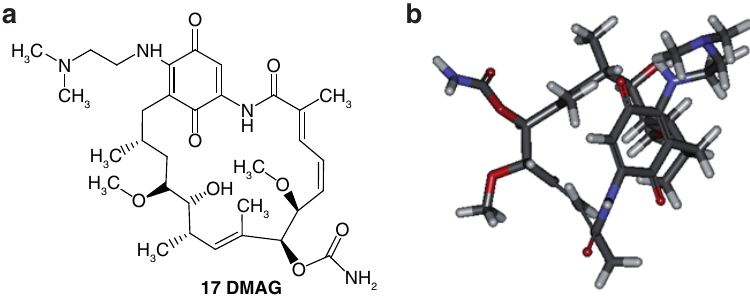
dynamics.Figure 2. a ) R 3 indicates the position that takes the substituents on the C-11 position of the macrocycle for the analogues of series 7 and b ) Structure bioactive of the